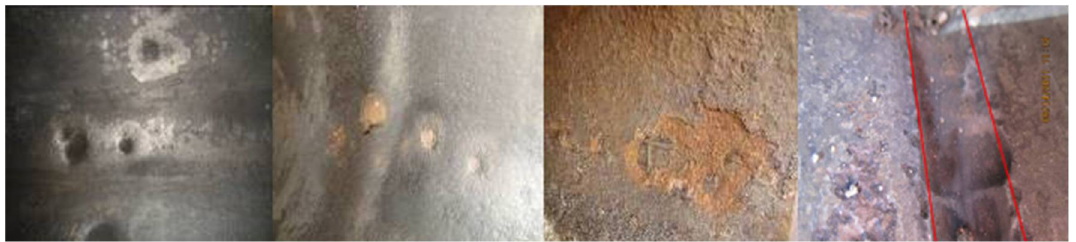
Figure 1. The typical corrosion morphology of the pipes in Tahe